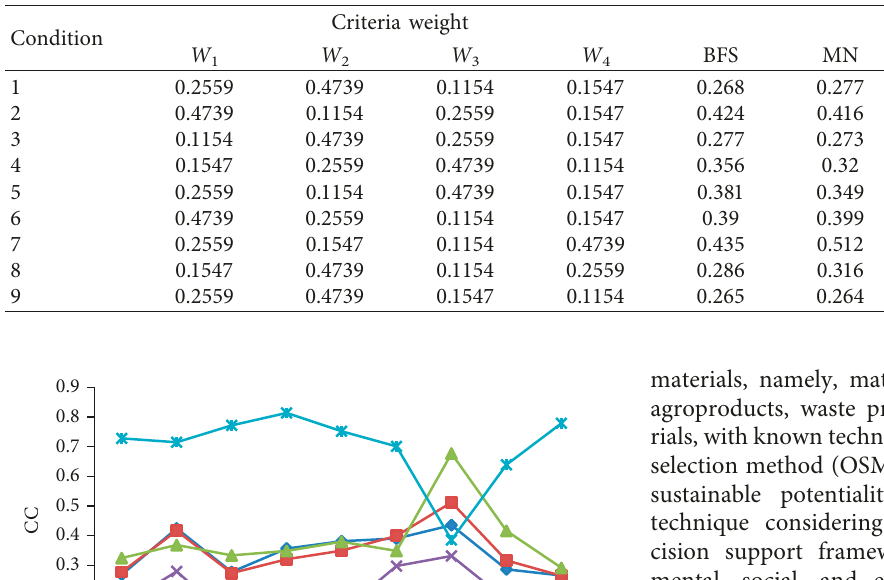
Table 10: Sensitivity analysis output.